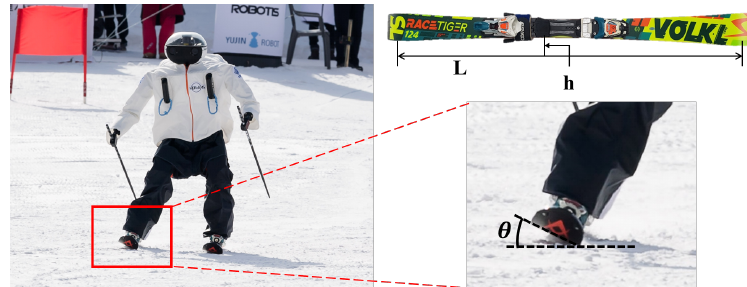
Figure 9. Curvature